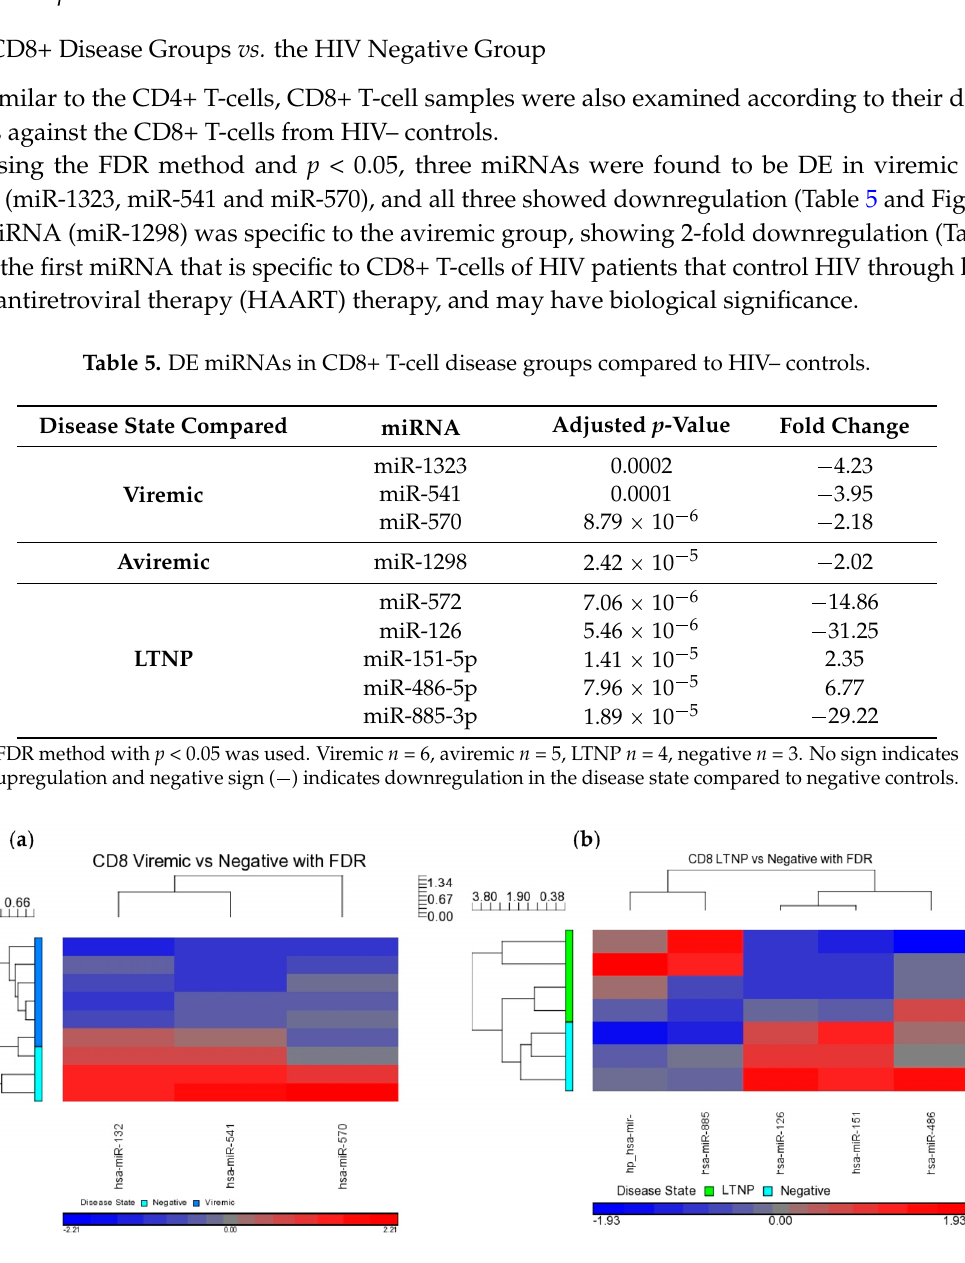
Figure 9. Heat maps indicating DE miRNAs in CD8+ disease group comparisons of viremic ( a ) and LTNP ( b ) compared to negative controls. Viremic n = 6, LTNP n = 4, negative n = 3.